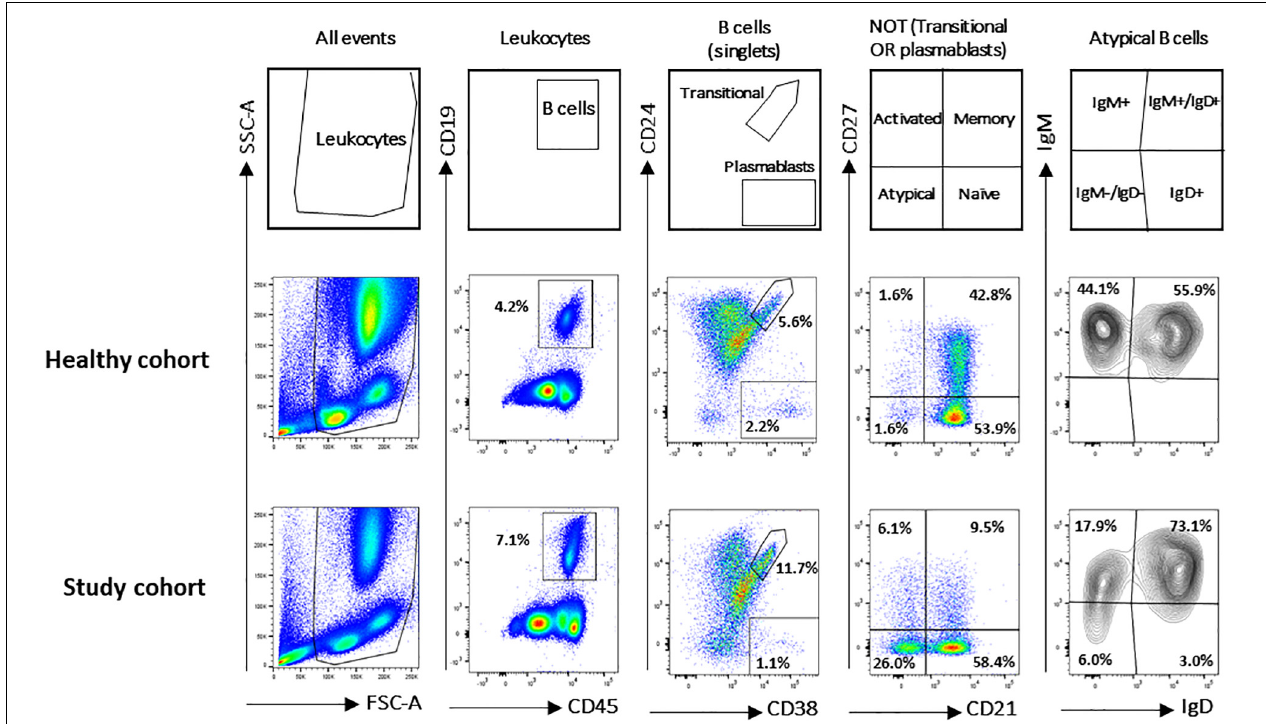
FIGURE 1 | Gating strategy for B-cell subsets identification in study and healthy cohorts. B-cell subsets were identified via CD19, CD24, CD27, CD38, IgM, IgG, IgD, and CD21 markers. Gating strategy on two representative blood samples is shown. Names defining the different B-cell populations are shown in the empty